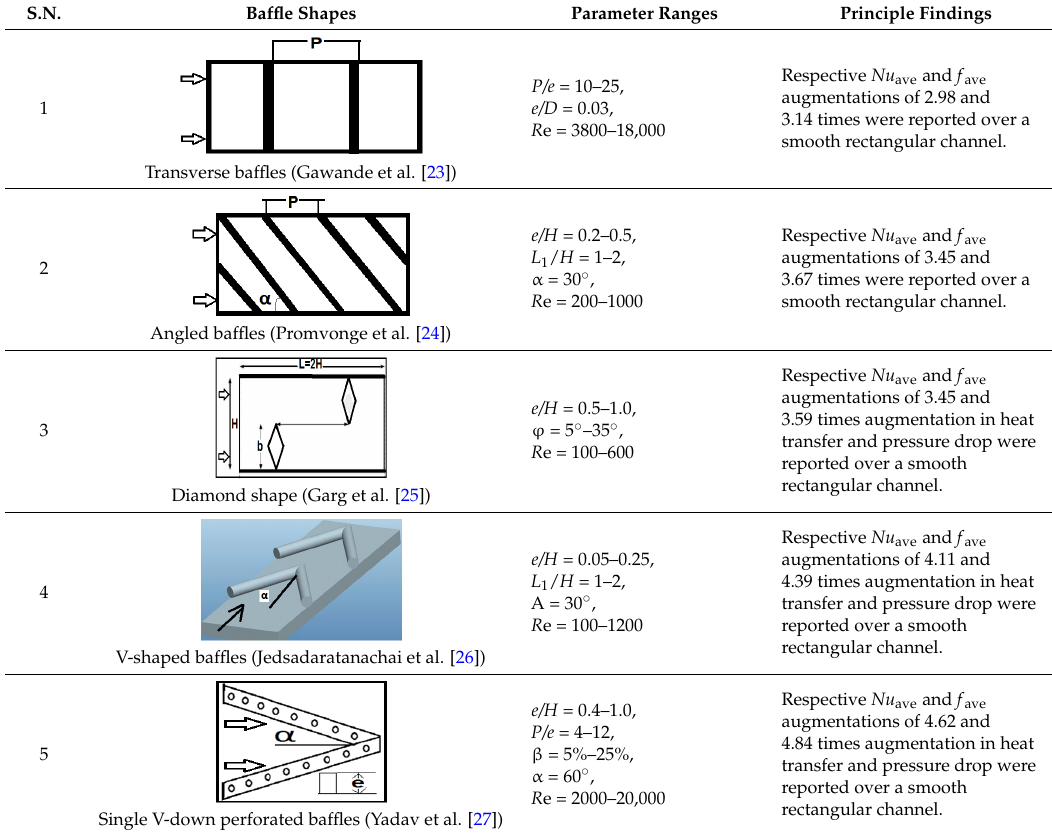
Table 2. Summary of results from a previous computational fluid dynamics (CFD)-based study using various baffle shapes in an air channel.